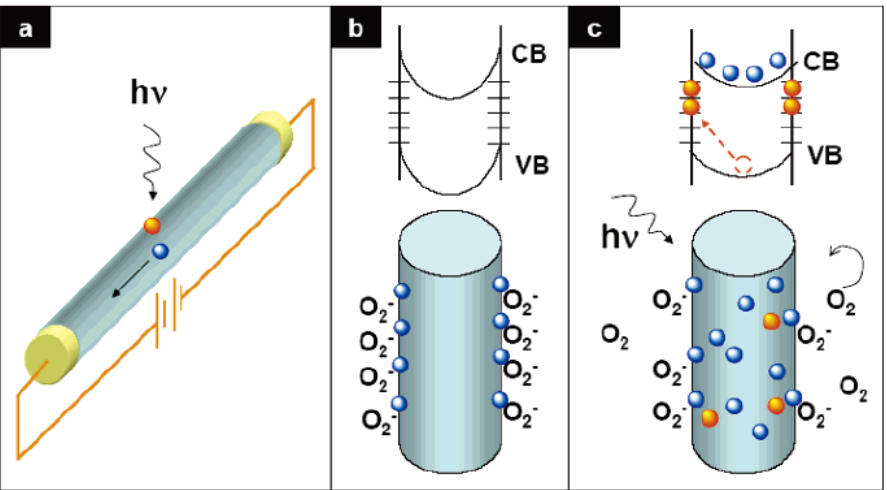
Figure 1. Photoconduction in NW photodetectors: (a) Schematic of a NW photodetector. Upon illumination with the photo-energy above Eg, electron-hole pairs are generated and holes are readily trapped at the surface. Under an applied electric field, the unpaired electrons are collected at the anode, which leads to the increase in conductivity. (b, c) Trapping and photoconduction mechanism in zinc oxide (ZnO) NWs: the top drawing in (b) shows the schematic of the energy band diagrams of a ZnO NW in dark, indicating band-bending and surface trap states. VB and CB are the valence and conduction bands, respectively. The bottom drawing shows oxygen molecules absorbed at the NW surface that capture the free electrons present in the n-type semiconductor forming a low- conductivity depletion layer near the surface. (c) Under light illumination, photogenerated holes migrate to the surface and become trapped, leaving behind unpaired electrons in the NW that contribute to the photocurrent. In ZnO NWs, the lifetime of the unpaired electrons is further increased by oxygen molecules desorption from the surface when holes neutralize the oxygen ions. Reproduced from